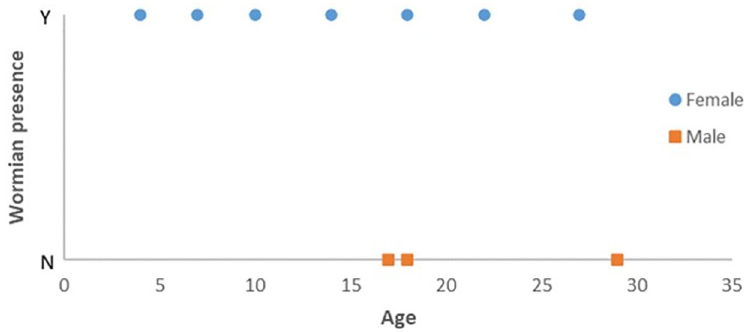
Fig 7. Distribution of subjects according to sex, age and Wormian bone presence. No trend is observed for any of these variables.